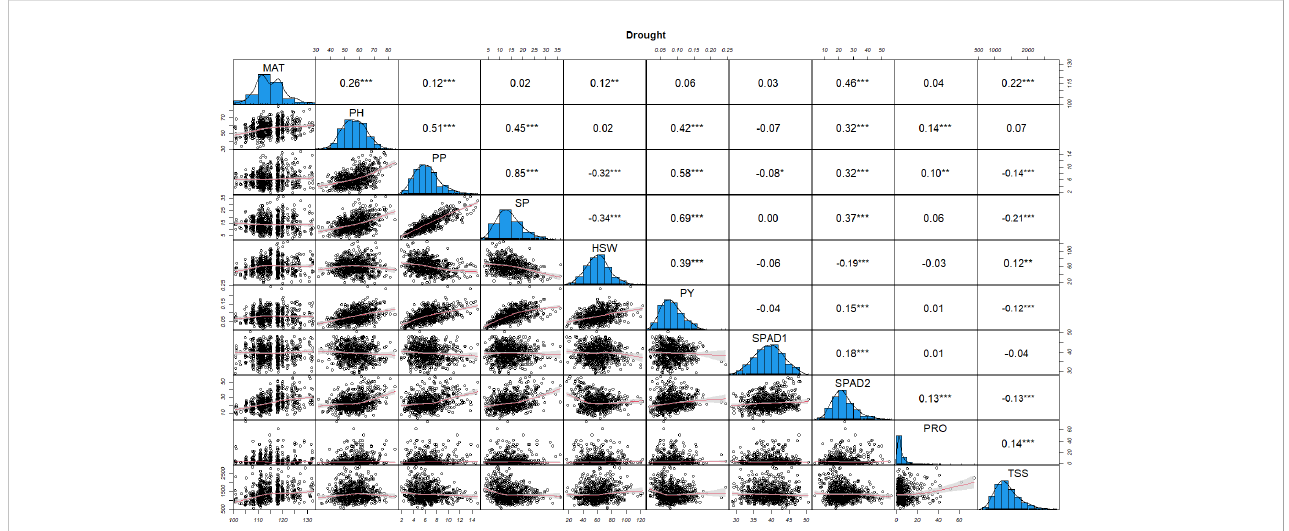
FIGURE 2 Distributions of phenotypic frequency and correlations between 10 morphological, phenological and physiological traits in drought stress conditions. The frequency distribution of each trait is shown on a central diagonal in the form of a histogram. Scatter plots of correlations between every pair of traits are shown in the areas below the diagonal, and numerical Pearson ’ s correlation coef fi cients (r), between every pair of traits are shown in the areas above the diagonal. The red line in the scatter plots represents the slope of the correlations. The x- and y- axes are the values of the measurements (PH in cm, HSW in grams and PY in kg). *, ** and *** indicate signi fi cance at P<0.05, P<0.01 and P<0.001,